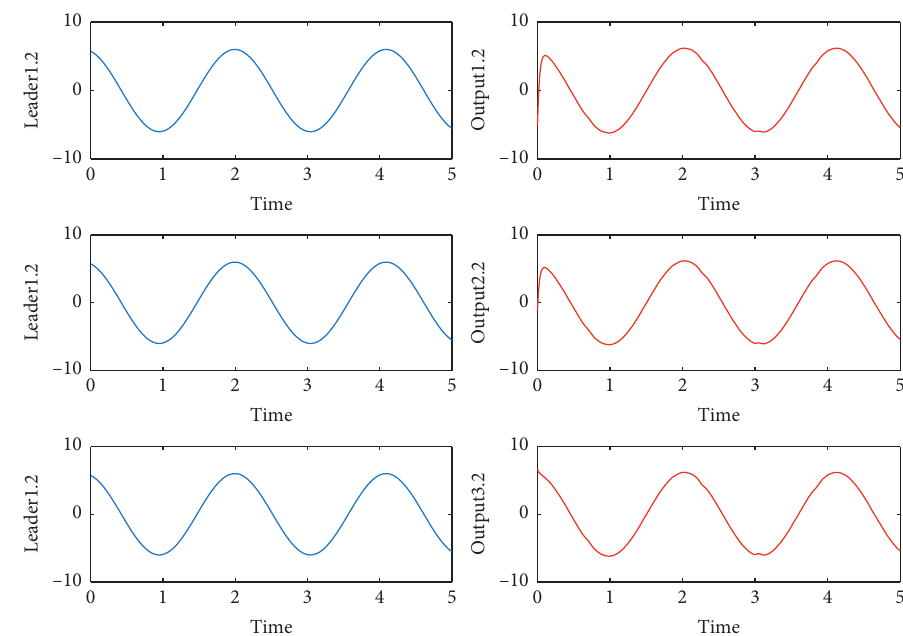
Figure 4: Performance of the second coordinate of the leader and three